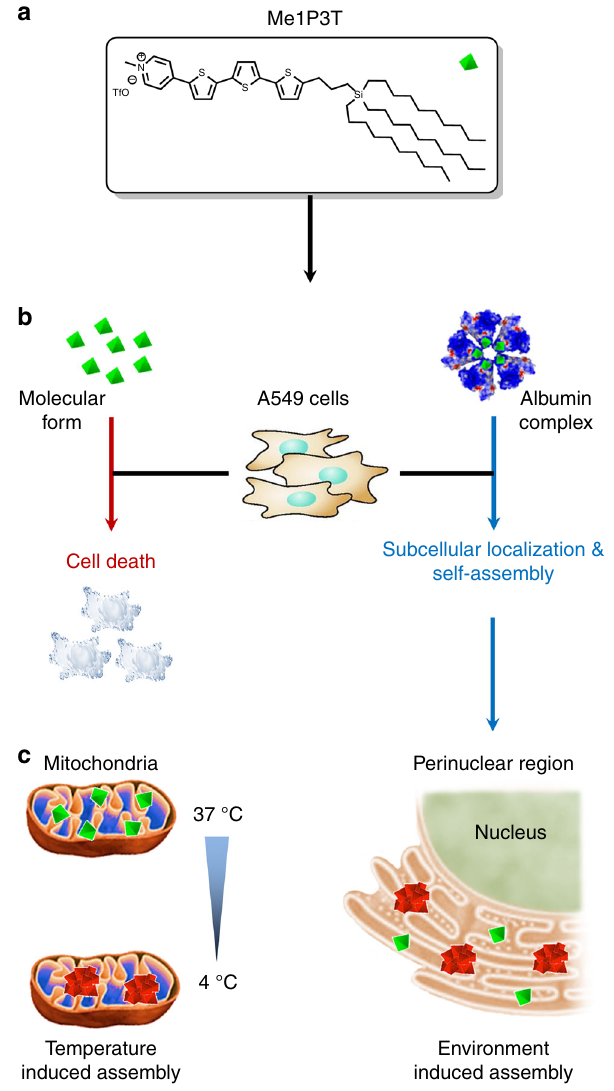
Fig. 10 Cellular response and controlled self-assembly of Me1P3T. a ,